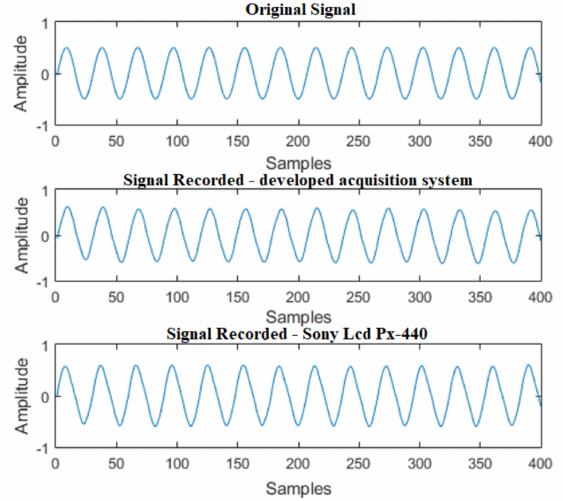
Figure 14. Acquisition of a single tone signal—1500 Hz sine wave.